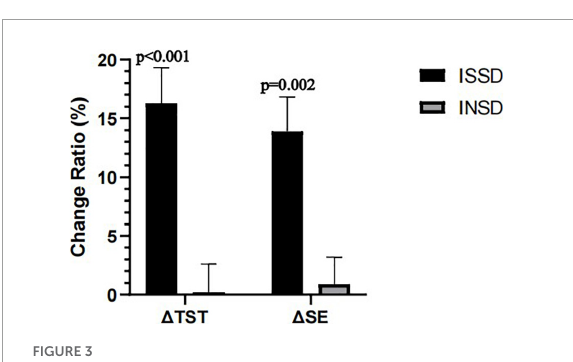
FIGURE3 Changes in TST and SE from pre-treatment to 6 week post-treatment between ISSD and INSD groups. INSD, insomnia with objective normal sleep duration; ISSD, insomnia with objective short sleep duration; SE, sleep efficiency; TST, total sleep time. All data were presented after control for age, gender and BMI. Error bars present standard